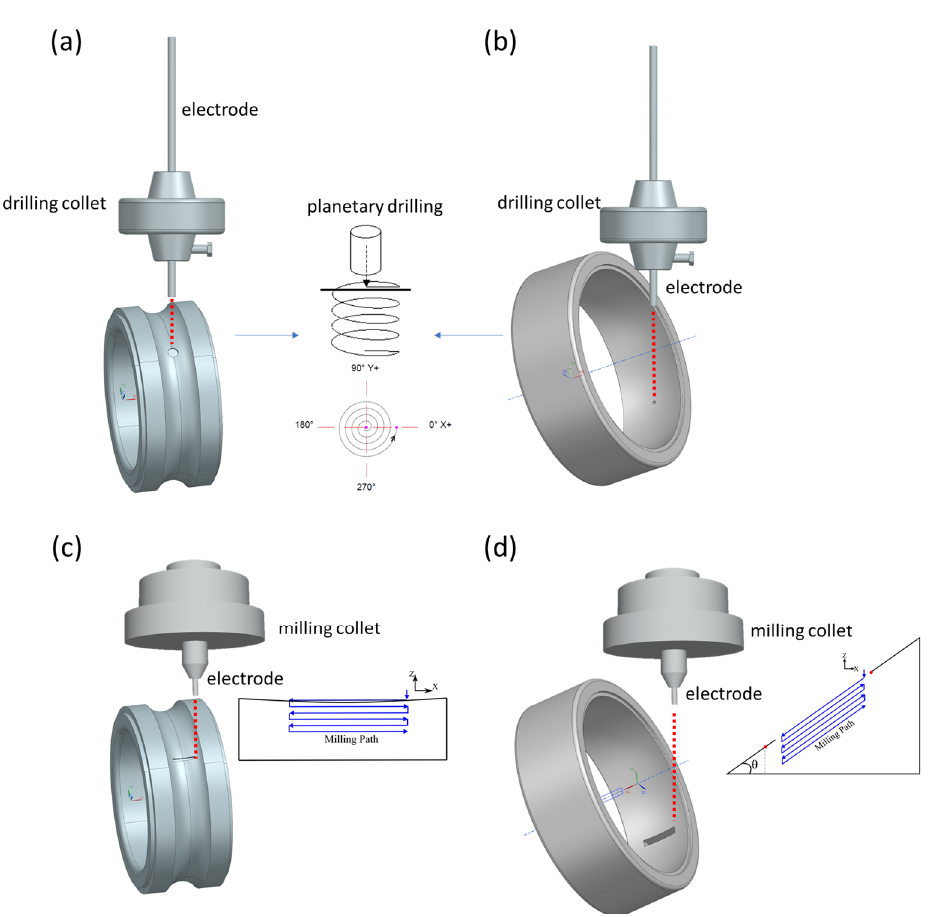
Figure 2. Micro-EDM drilling and milling strategies for generating artificial defects. Drilling of artificial pitting onto the ( a ) bearing inner ring and ( b ) bearing outer ring; milling of artificial spalling onto ( c ) bearing inner ring and ( d ) bearing outer ring. (Sketch not to scale).